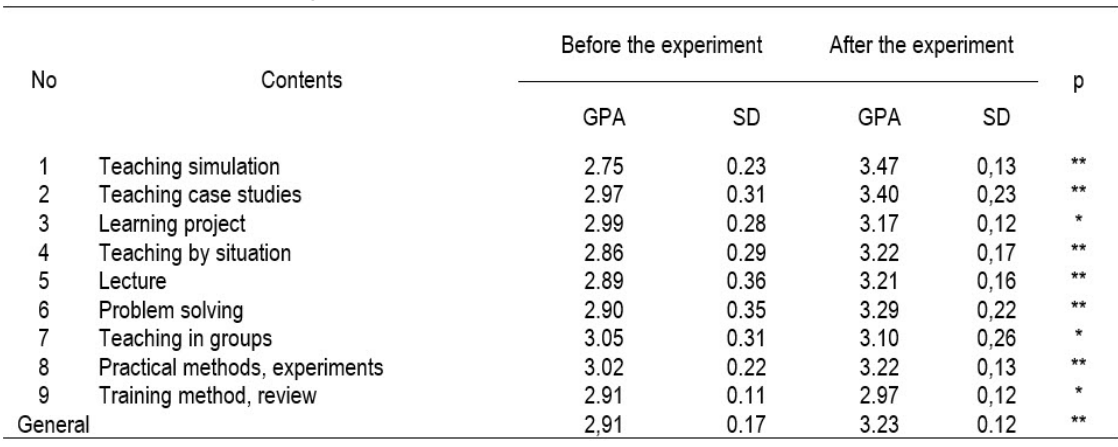
Awareness of teaching methods before and after the experiment